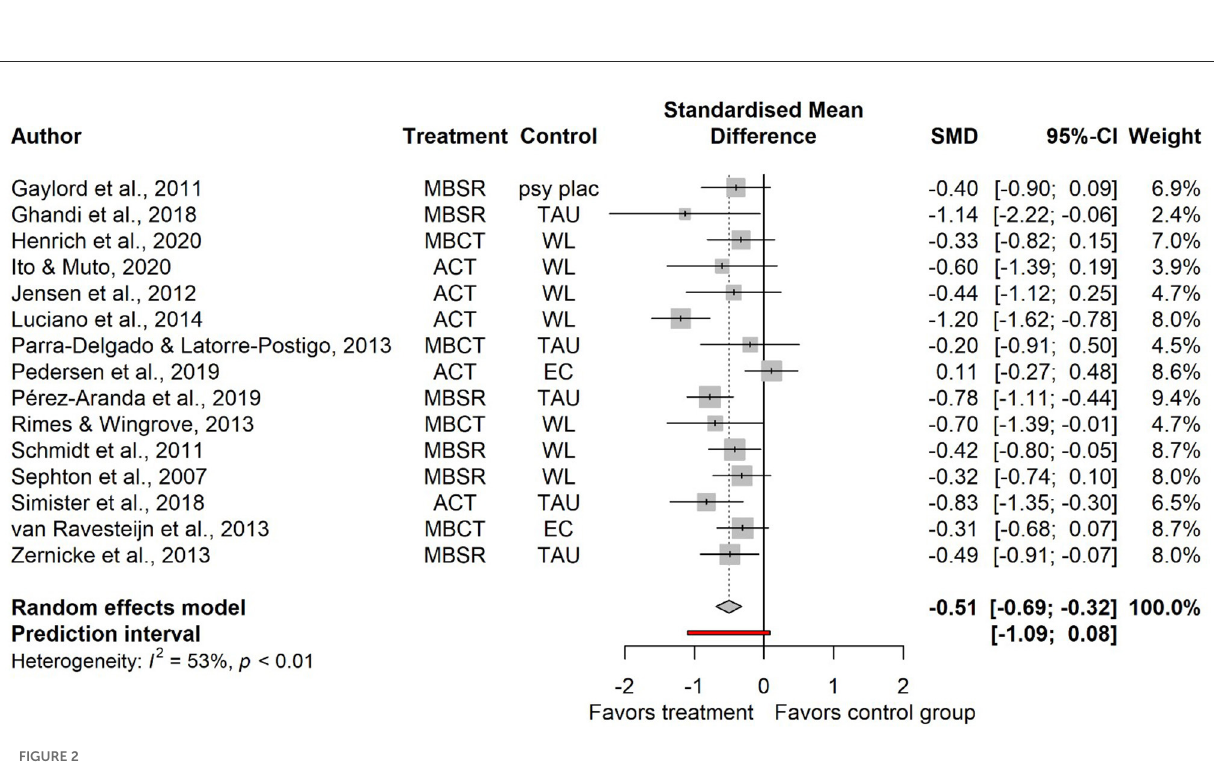
FIGURE2 Forest plot for somatic symptom severity